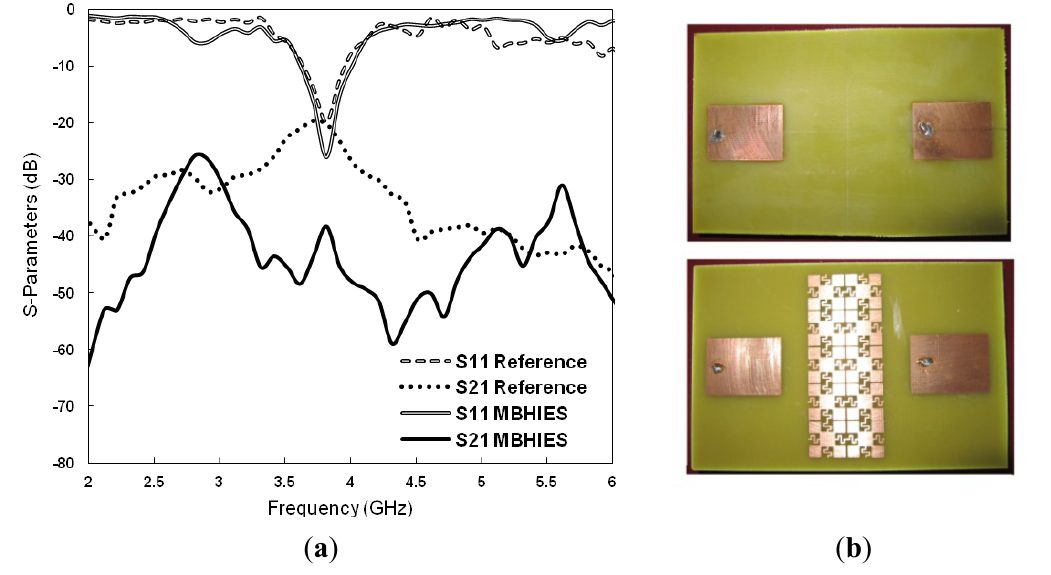
Figure 11. ( a ) Measured S- parameters of the microstrip antenna array; ( b ) fabricated prototypes.